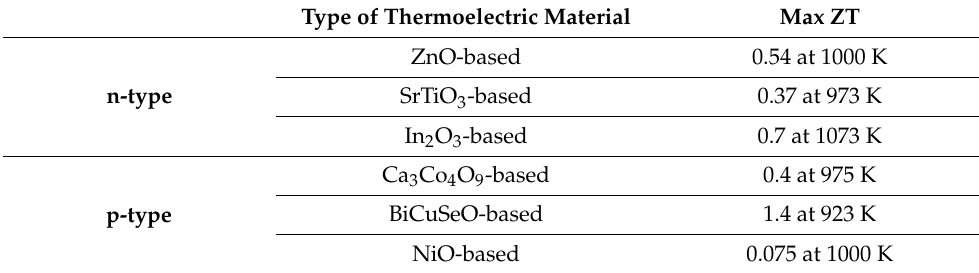
Table 3. The maximum figure of merit ZT for various oxide-based thermoelectric materials [94]. Type of Thermoelectric Material Max